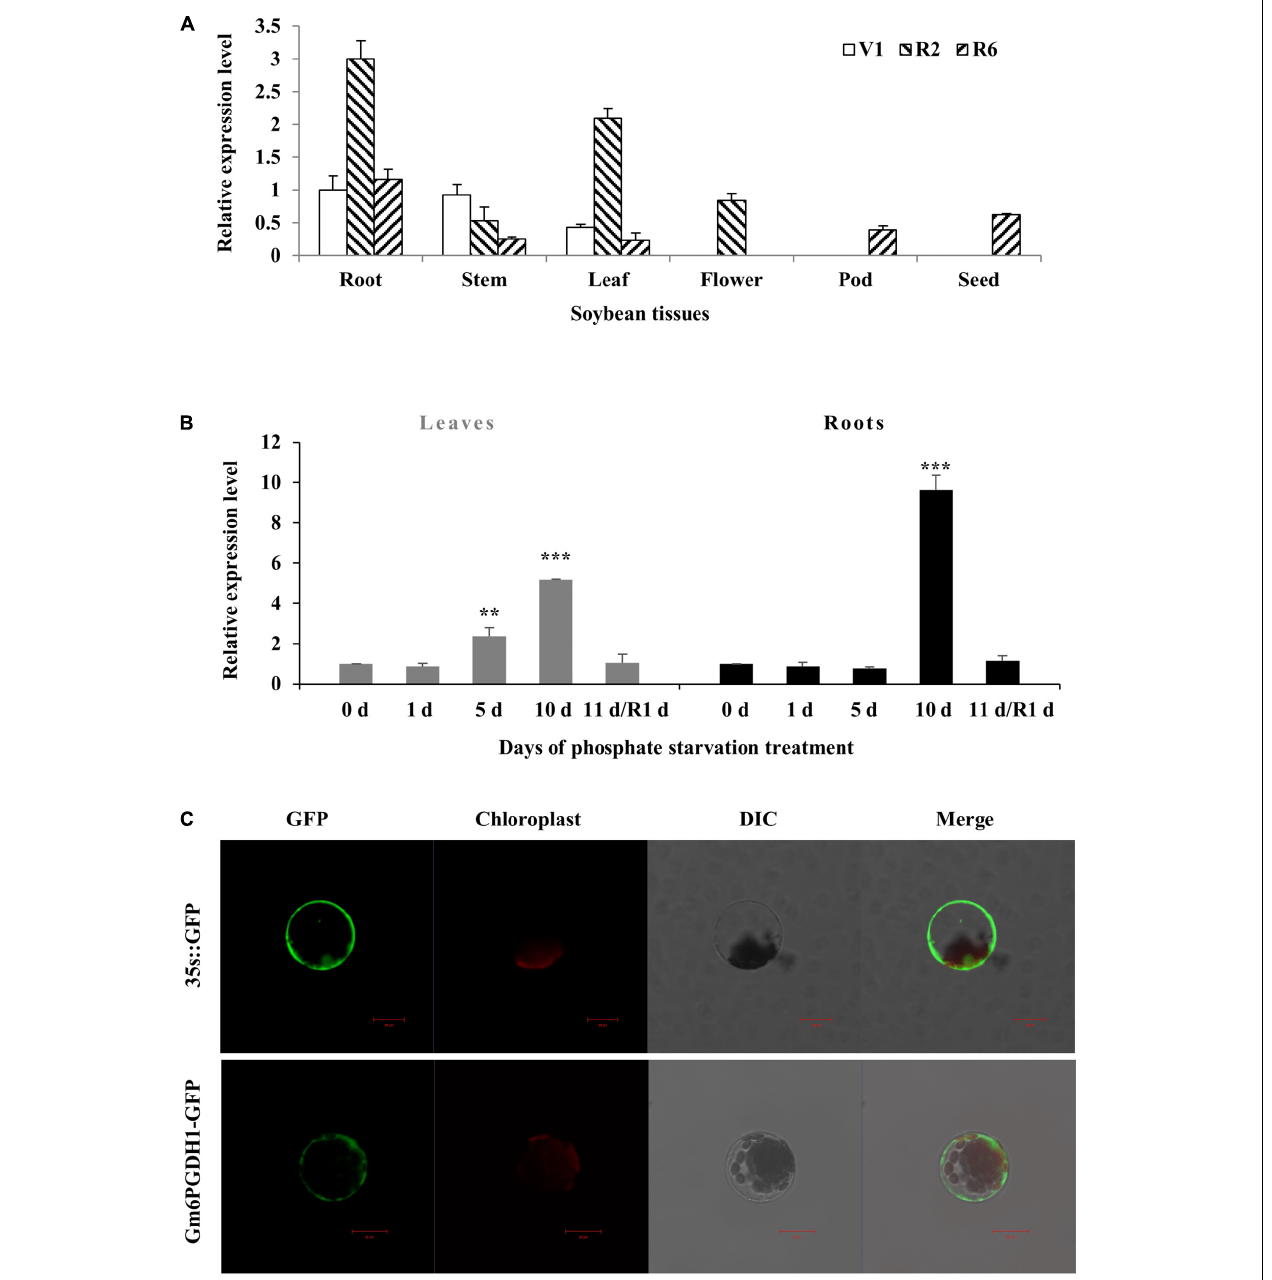
FIGURE 2 | Expression patterns and subcellular localization of Gm6PGDH1 . (A) Tissue-specific transcript abundance of Gm6PGDH1 in root, stem, leaf, flower, pod, and seed at different developmental stages, the first trifoliate stage (V1), full bloom stage (R2), and full seed stage (R6). (B) Time course of the Gm6PGDH1 expression in response to Pi starvation. R1d means resume Pi supply for 1 day. Actin was used as an internal control. Data means ± SD ( n = 3). Data that are significantly different from the corresponding controls are indicated (Student’s t -test, ** P < 0.01; *** P < 0.001). (C) Subcellular localization of the Gm6PGDH1 protein in protoplasts of Arabidopsis . Scale bar = 20 µ